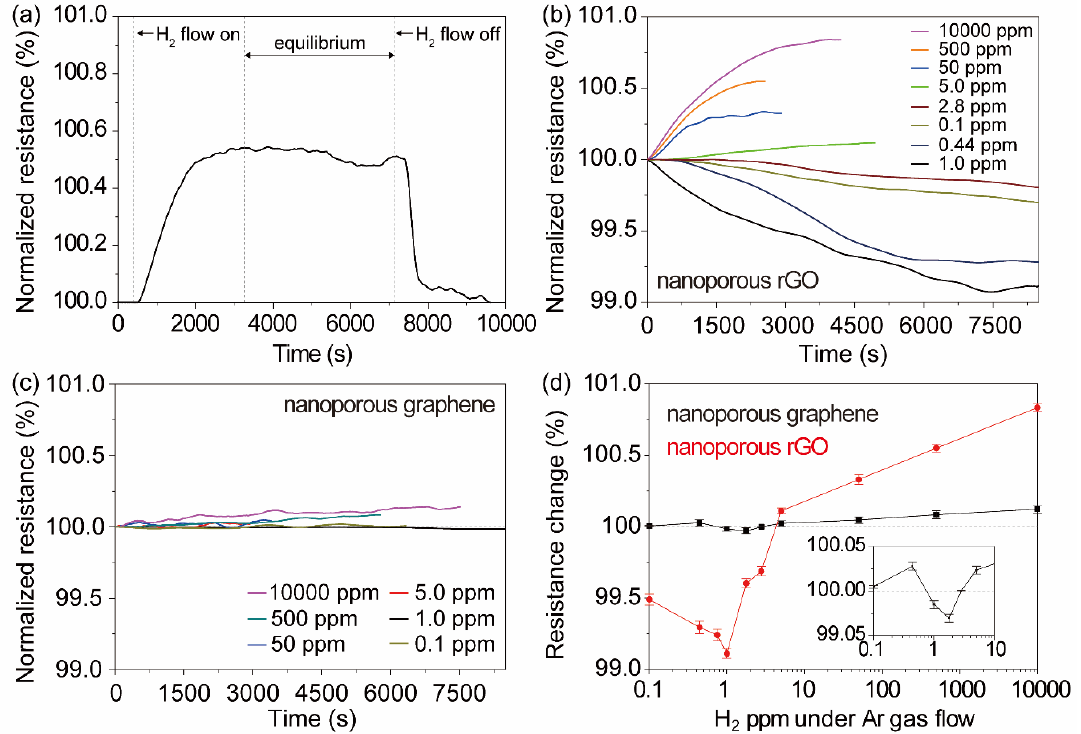
Figure 3. Hydrogen detection ability of nanoporous rGO under H 2 / Ar gas flow at 1 atmosphere. ( a ) Reversible feature of nanoporous rGO. Time dependence of resistance change (%) on ( b ) nanoporous rGO and ( c ) pristine nanoporous graphene. ( d ) H 2 volume concentration (ppm) dependence of resistance change (%) of nanoporous rGO with an oxygen content of 20.0 at.% and pristine nanoporous graphene. Error bars were estimated by fluctuations during measurements.